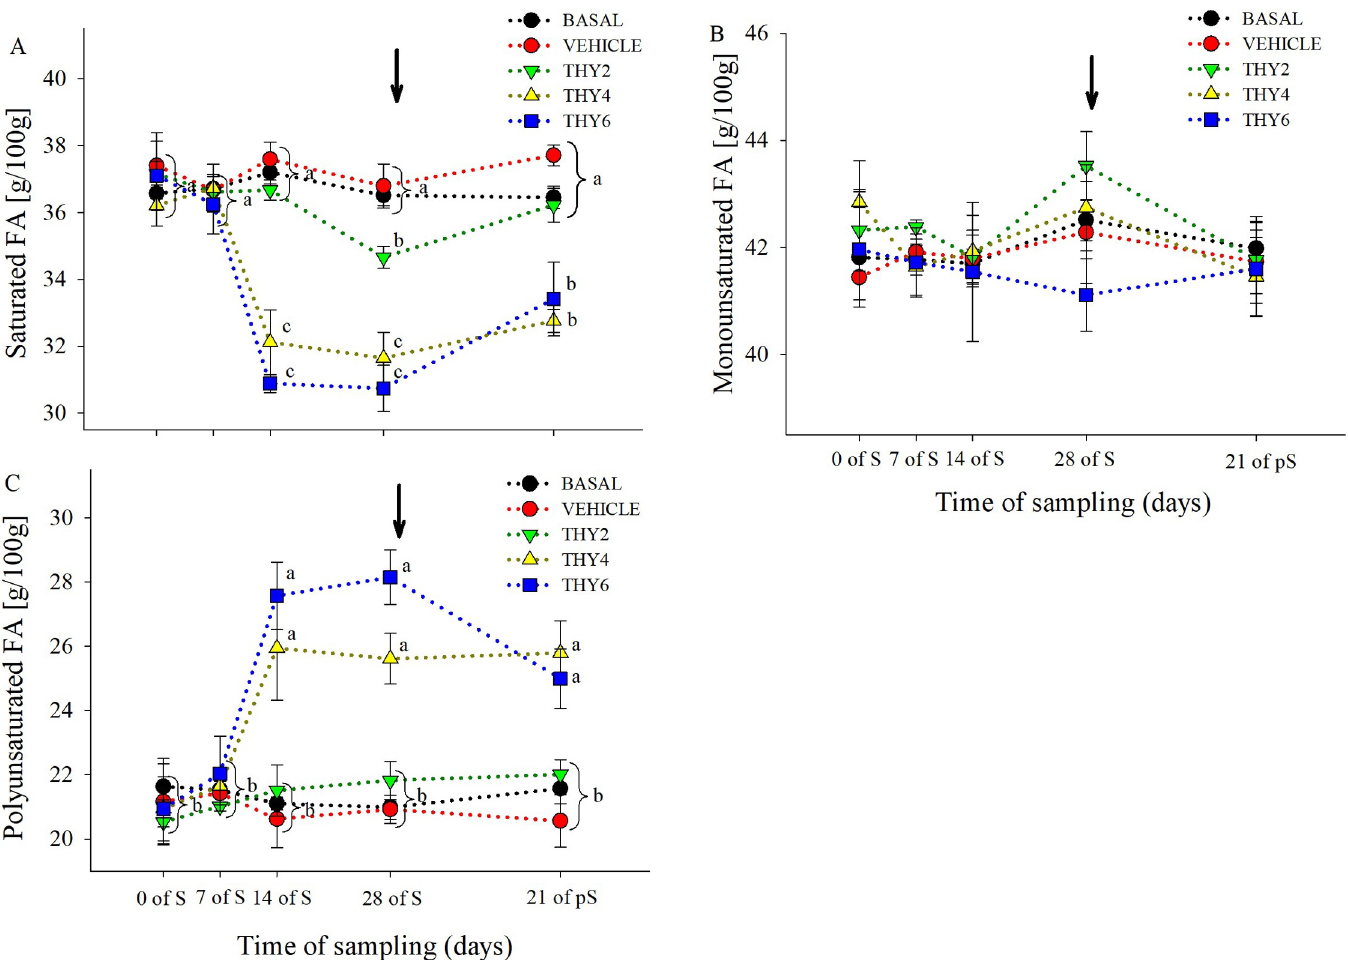
Fig 3. Concentration of saturated, monounsaturated and polyunsaturated fatty acids of quail egg yolk. Mean ± SEM of content (g/100 g FAME) of (A) saturated (myristic + pentadecanoic + palmitic + stearic acids), (B) monounsaturated (palmitoleic + oleic acids) and (C) polyunsaturated (linoleic + linolenic + arachidonic + docosahexaenoic + eicosapentaenoic + docosapentaenoic acids) fatty acids of quail egg yolk laid by females fed on the control diets (BASAL and VEHICLE) or supplemented with 2, 4, and 6.25 g of thymol/kg of feed (THY2, THY4 and THY6, respectively) at 0, 7, 14, and 28 days of the supplementation period (S) and after 21 days of supplement withdrawal (pS). Arrow pointing down indicates the end of the S period. Brackets refer to measurements within a time of sampling. Different letters (a, b, c, d) indicate statistical differences. The same 25 females (5 per diet supplied) were analyzed on each of the five sample points (125 eggs total).